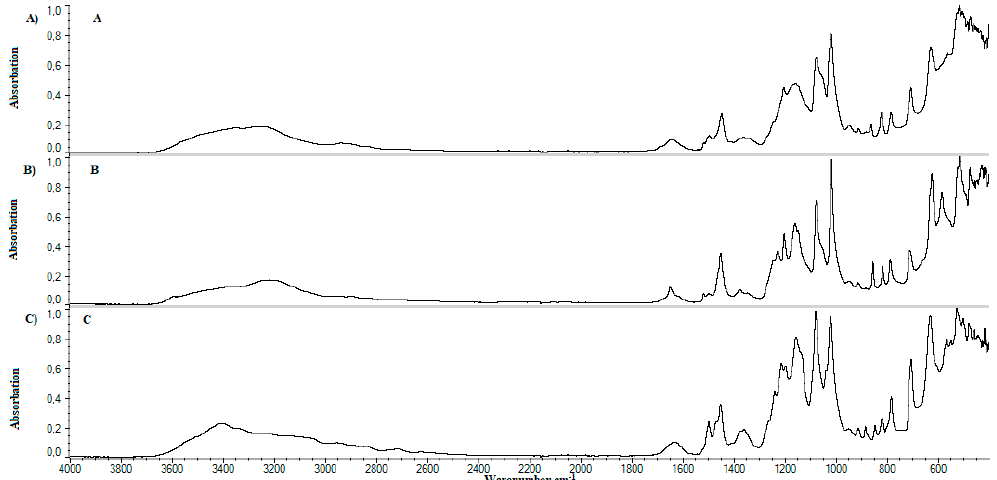
Figure 8. Comparison of spectrum FTIR for samples without cholesterol and lecithin. ( A ) Sample A; ( B ) sample B; ( C ) sample C.